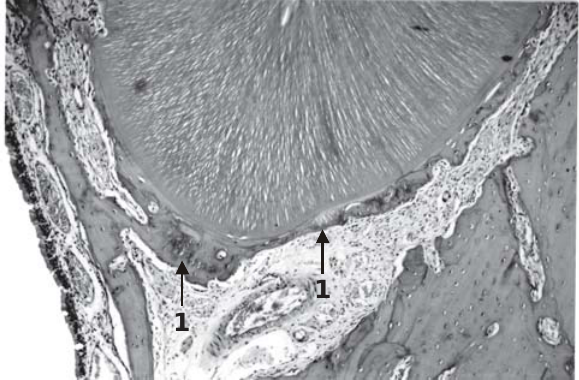
FIGURE 2- Group II. Healthy cementum covered by periodontal ligament remnants (1). Hematoxylin-eosin (original magnification X63)